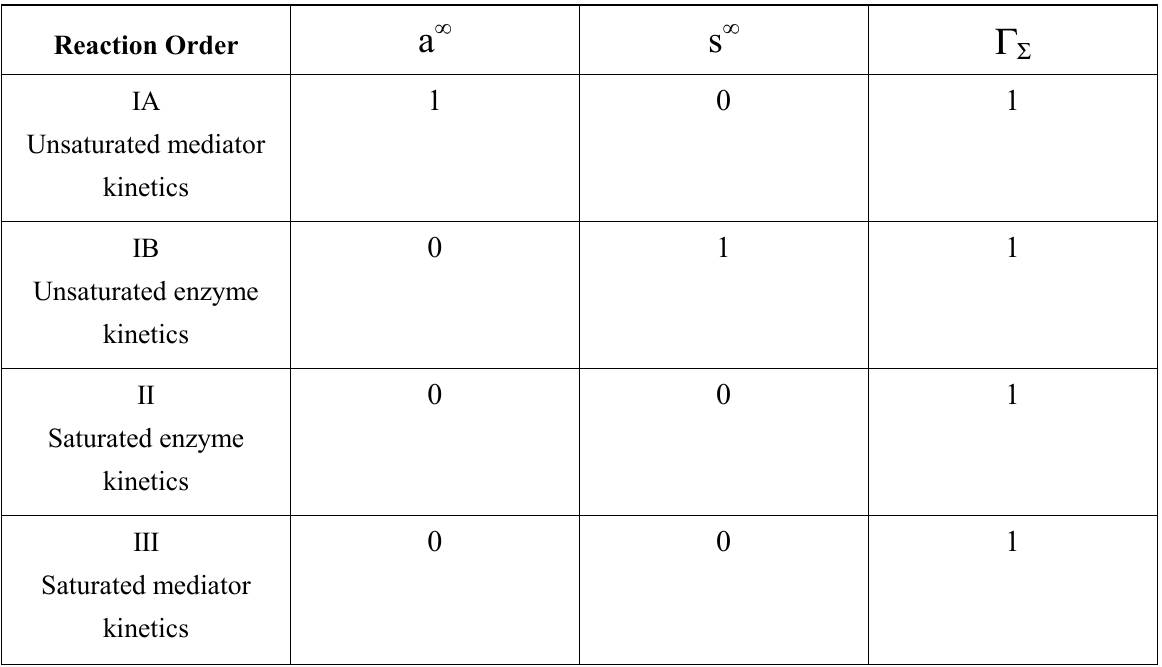
Table 2. Mechanistic indicators for immobilized enzyme monolayer